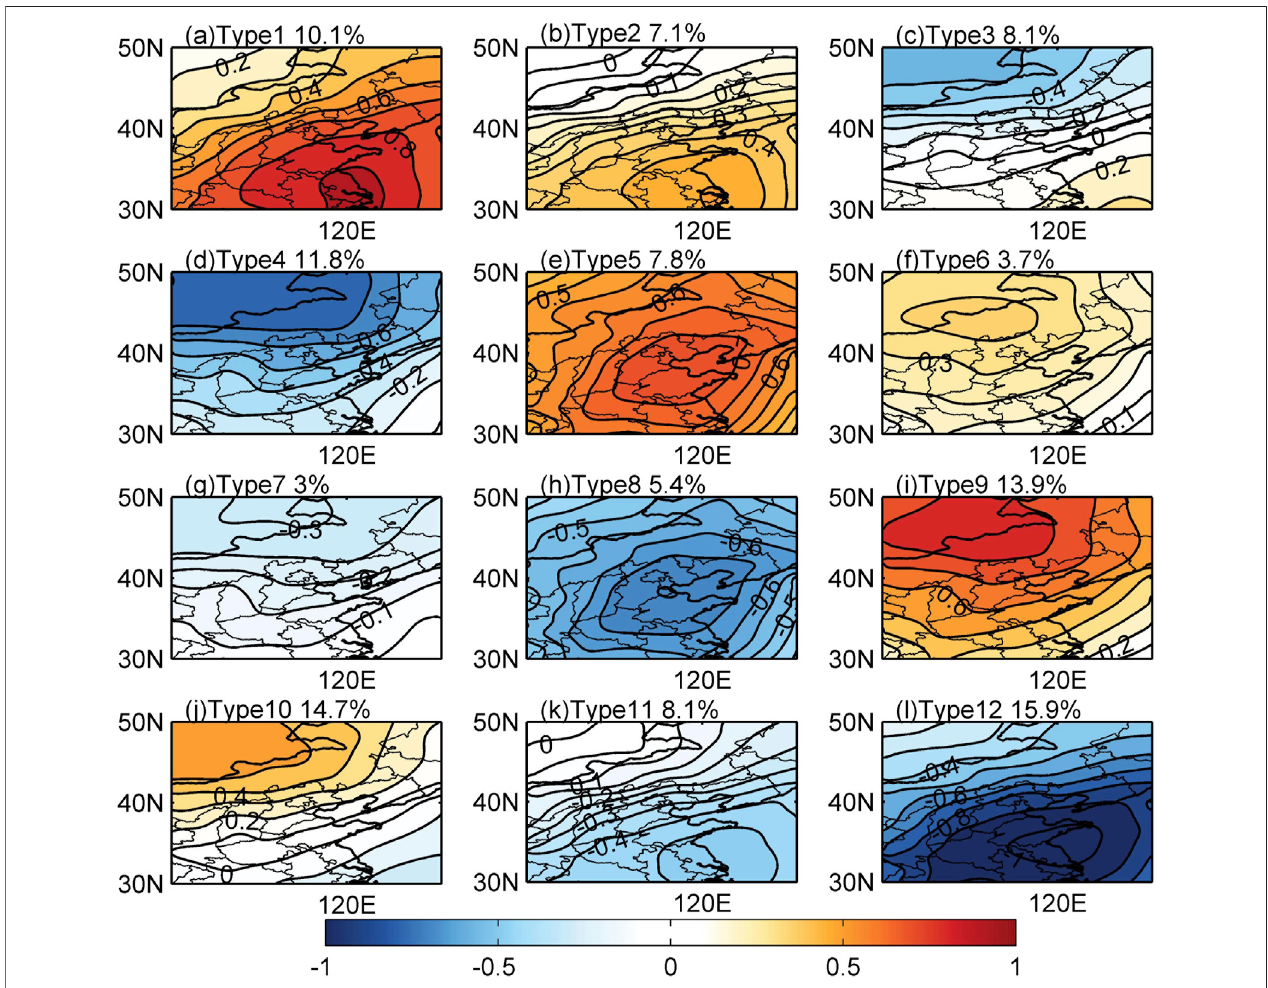
FIGURE 6 | Mean patterns of normalized SLP and frequencies of occurrence (numbers above each panel) of 12 circulation types (A – L) based on ERA5 reanalysis data for the climatology. All samples are normalized before being input into the input layer.